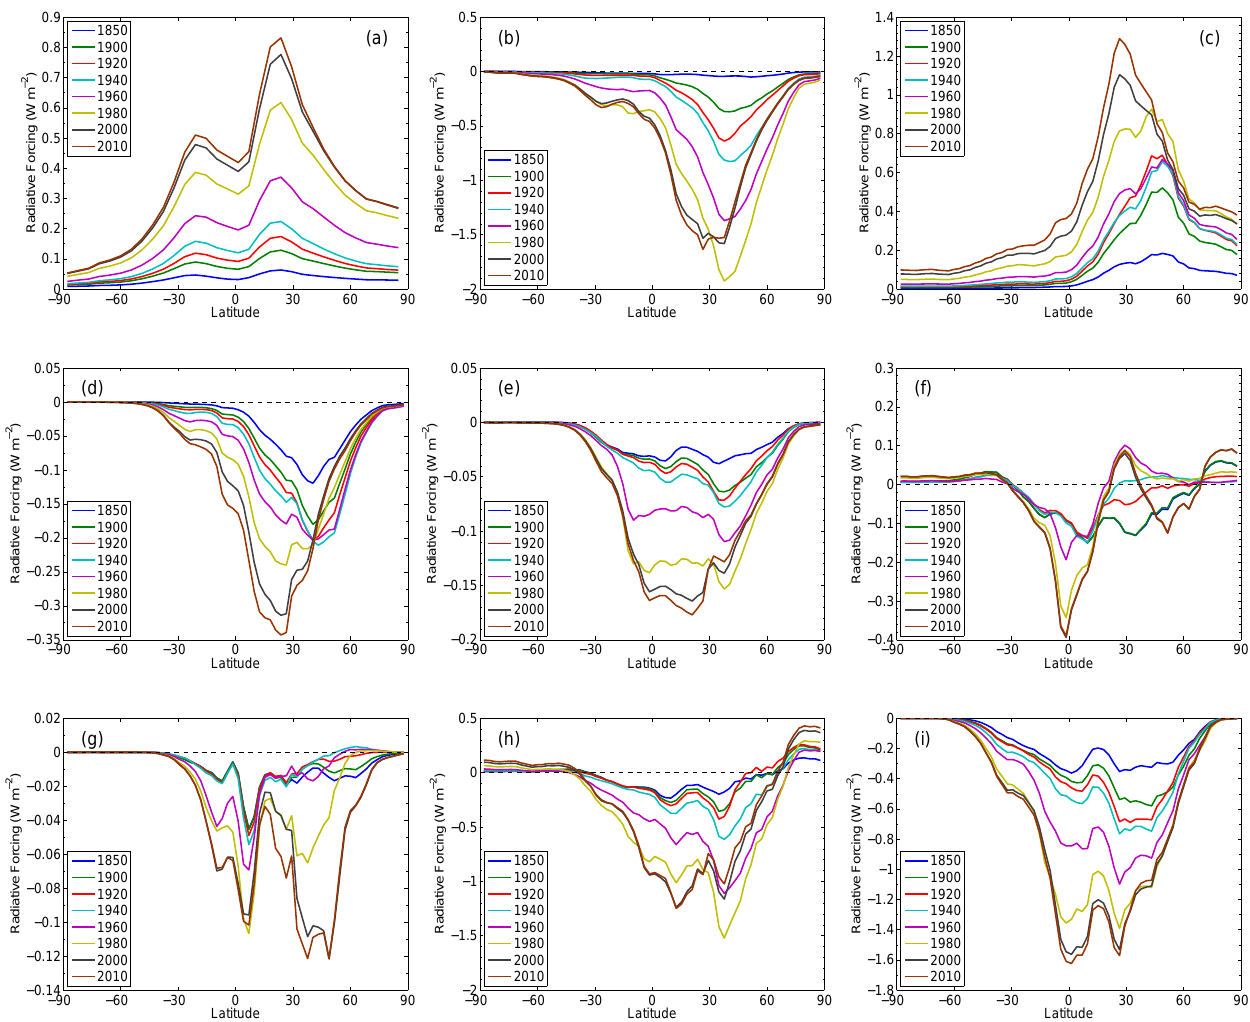
Fig. 3. Zonal mean RF for selected years for tropospheric ozone (a) , direct aerosol effect of sulphate (b) , FFBF BC (c) , FFBF OC (d) , SOA (e) , BB aerosols (f) , nitrate (g) , total direct aerosol effect (h) and the cloud albedo effect (i) . Figure 3: Zonal mean RF for selected years for tropospheric ozone (a), direct aerosol effect of sulphate (b), FFBF BC (c), FFBF OC (d), SOA (e), BB aerosols high altitude at mid-latitudes in the NH due to convective transport from the boundary layer and emissions from avia- (f), nitrate (g), total direct aerosol effect (h) and the cloud albedo effect (i). tion. At high altitudes, above the equator, there is a decrease in the NO x concentrations. This is in the same region as OH decreased (Fig. 2e) due to increased loss through reaction with CO and CH 4 leading to increased HO 2